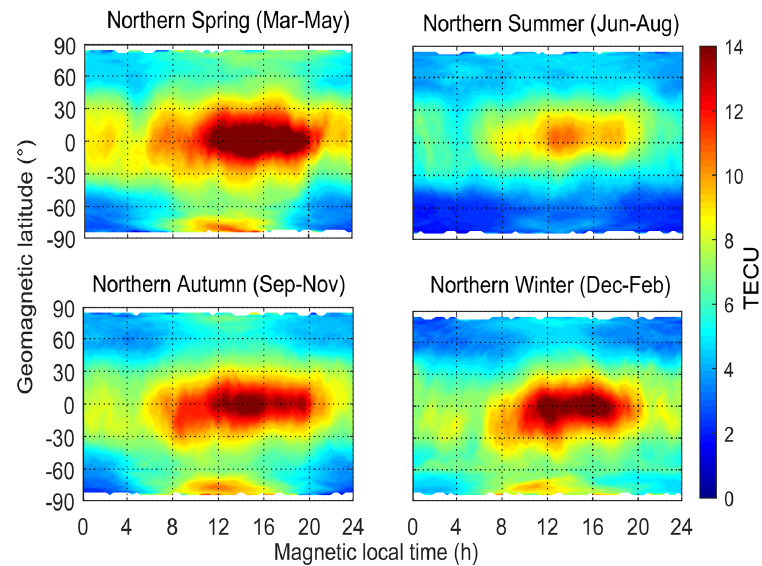
Figure 9. Seasonal variation of plasmaspheric TEC in 2014.